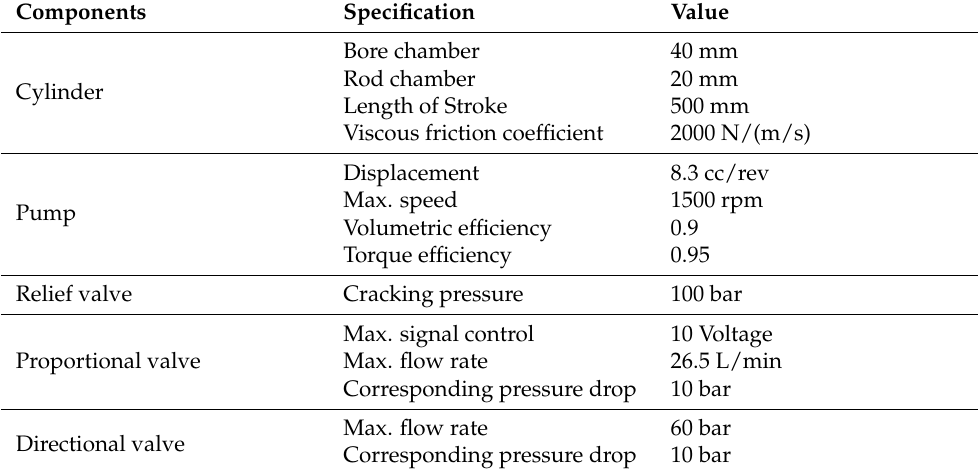
Table 4. The setting parameter of the NIMV system.